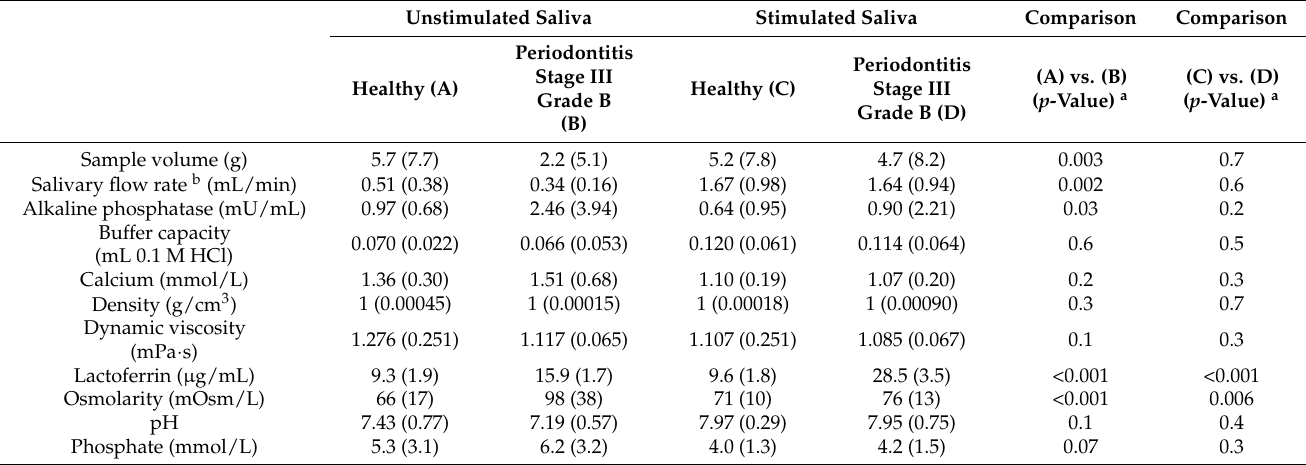
Table 2. Specific salivary parameters in median (IQR) obtained from stimulated and unstimulated saliva in healthy and periodontal patients.